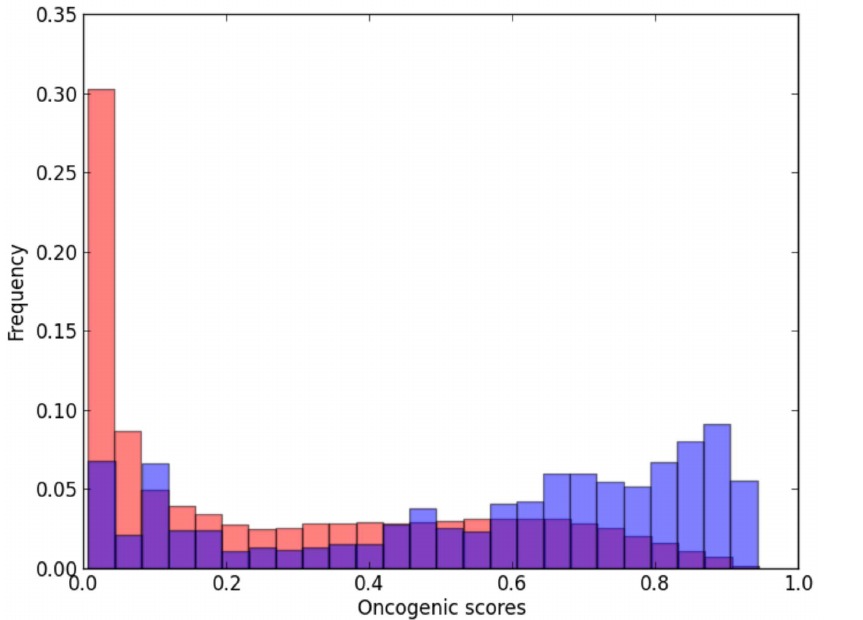
Figure 5. Frequency distribution of potential oncogenic interactions per intervals of oncogenic scores. The blue and red bars show, respectively, the frequency distributions of potential oncogenic interactions and all interactions in the wINHGI per 0.4 intervals of oncogenic scores.